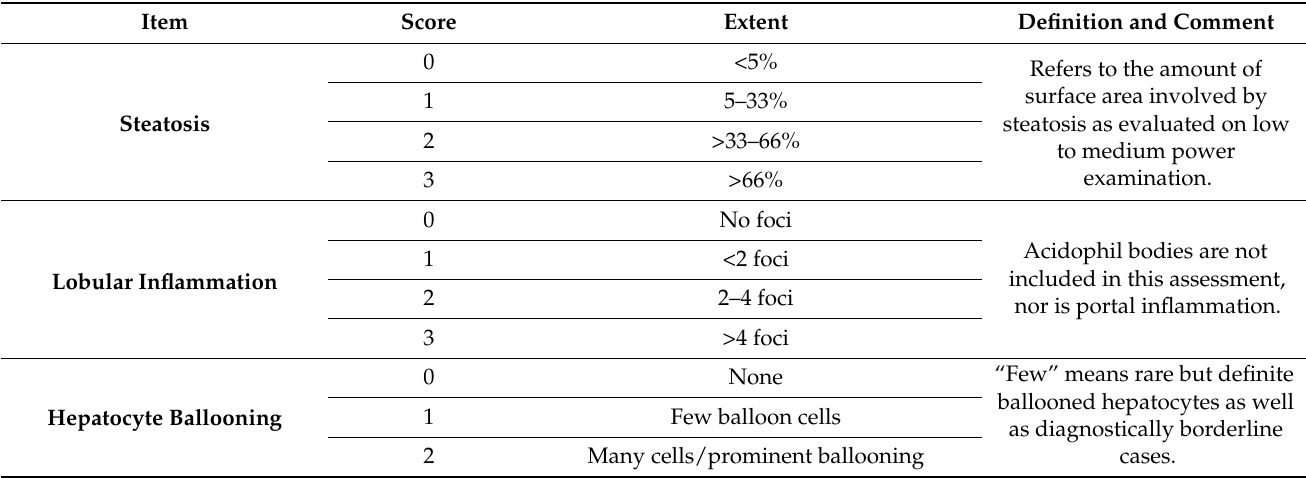
Table 5. NAFLD Activity Score (NAS)